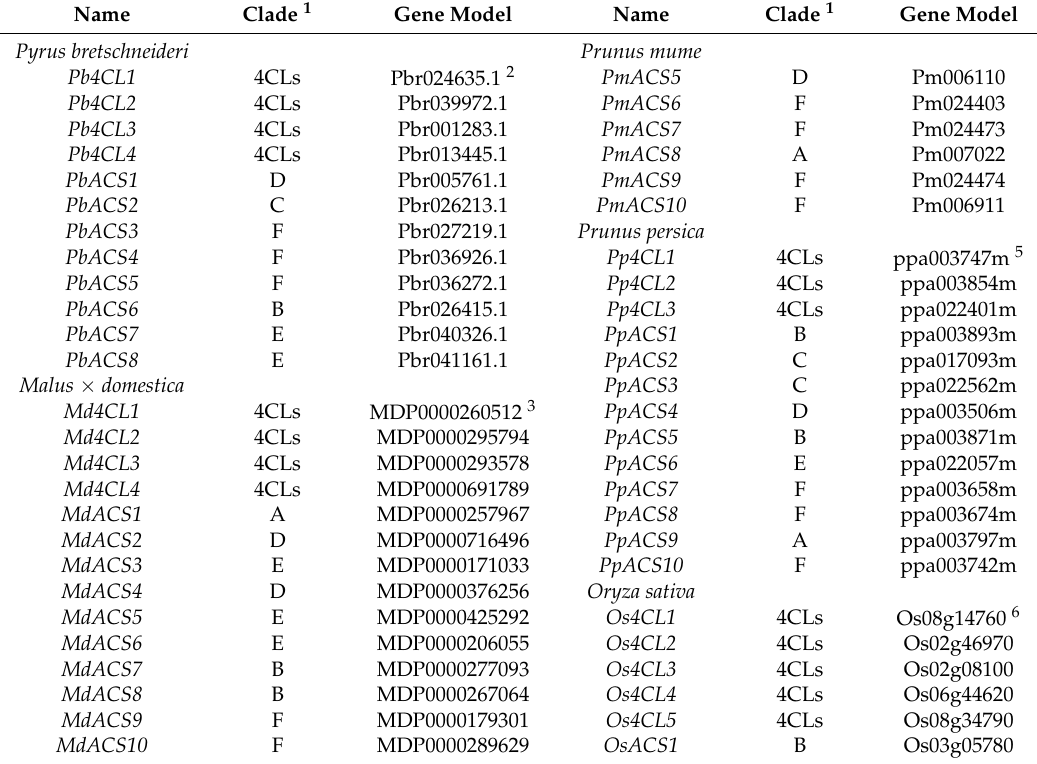
Table 1. Oryza sativa , Arabidopsis , Malus x domestica , Prunus mume , Prunus persica , and Pyrus bretschneideri 4-coumarate:coenzyme A ligase (4CL) and acyl-CoA synthetase (ACS)